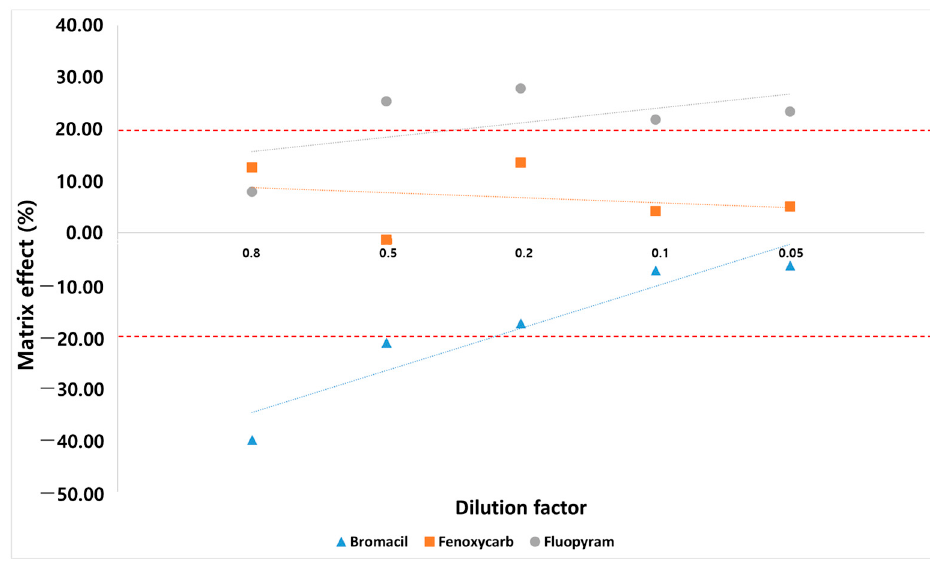
Figure 4. Three cases of matrix effect change affected by